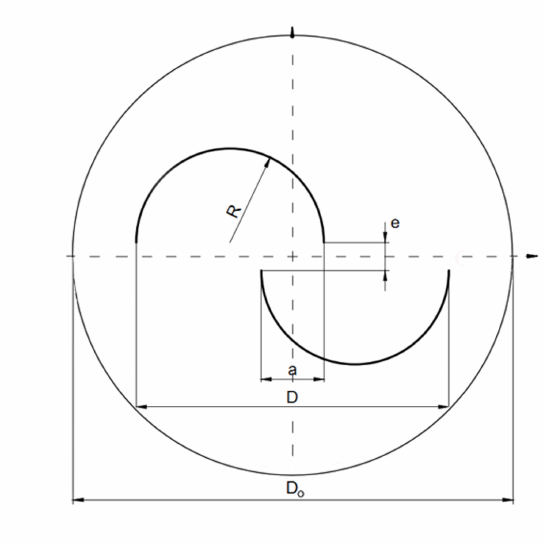
Figure 2: Geometrical parameters of the Classical Savonius wind